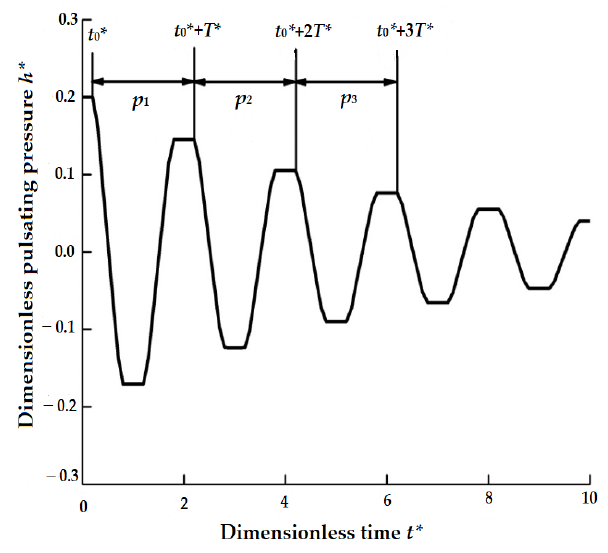
Figure 2. Curve of dimensionless fluctuating pressure with dimensionless time.